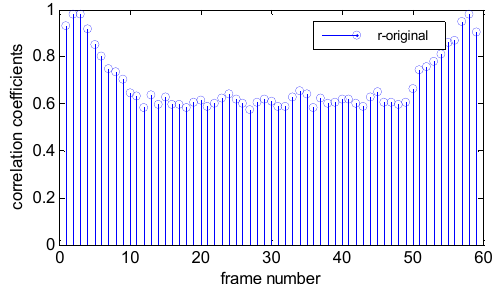
Figure 3. Correlation coefficients of original video (person15_jogging, frames 143–202).